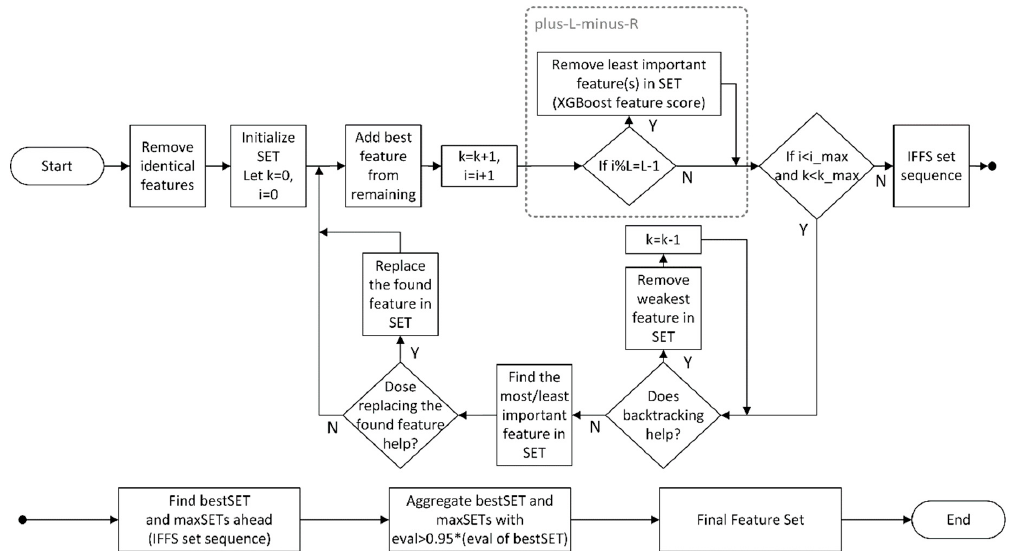
Figure 4. Flow chart of feature selection, the revised improved forward floating selection (IFFS).